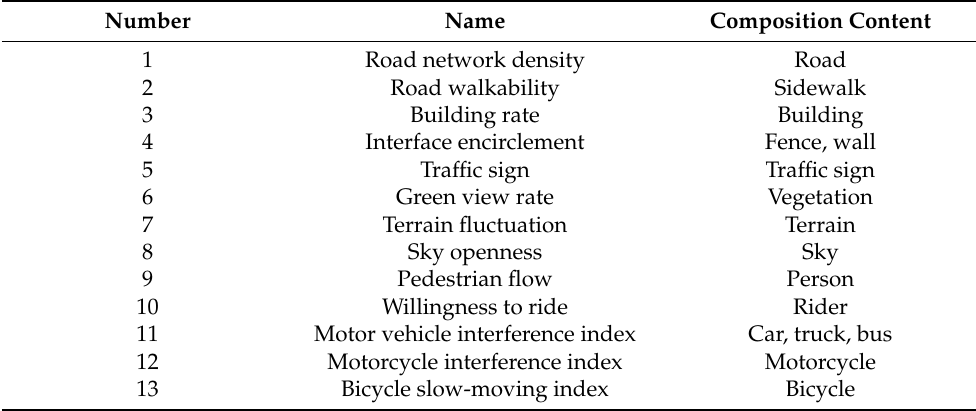
Table 2. Independent